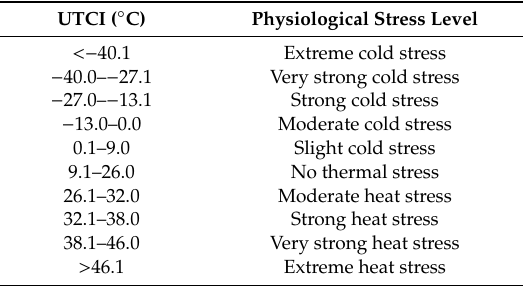
Table 1. Universal Thermal Climate Index (UTCI) Assessment Scale: UTCI is categorized in terms of thermal stress